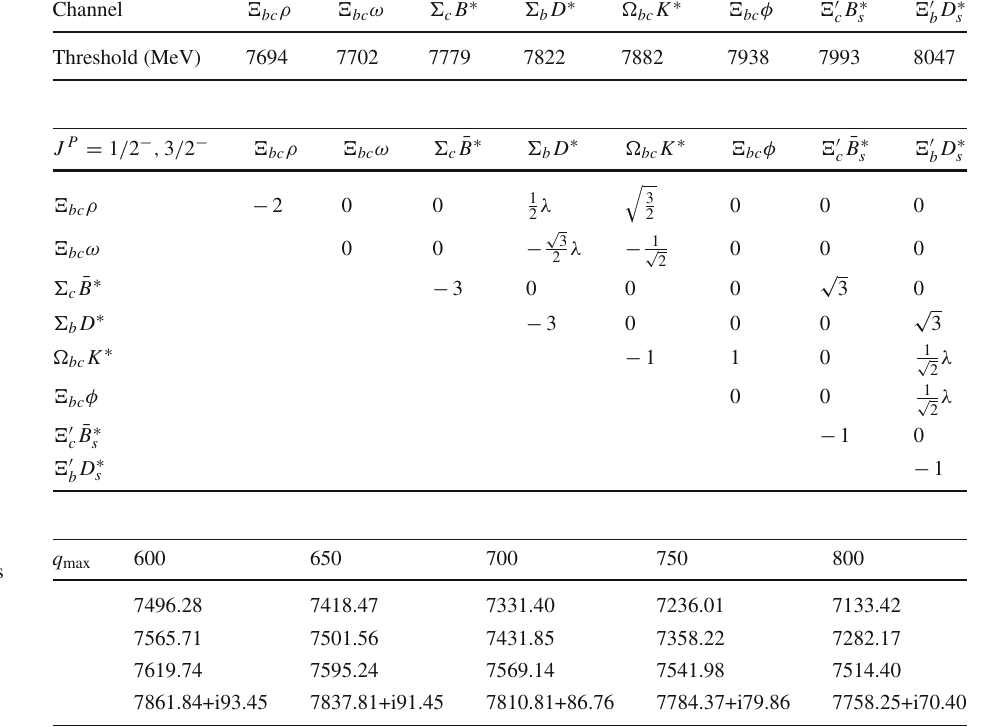
for sector J P = 1 / 2 − , 3 / 2 −